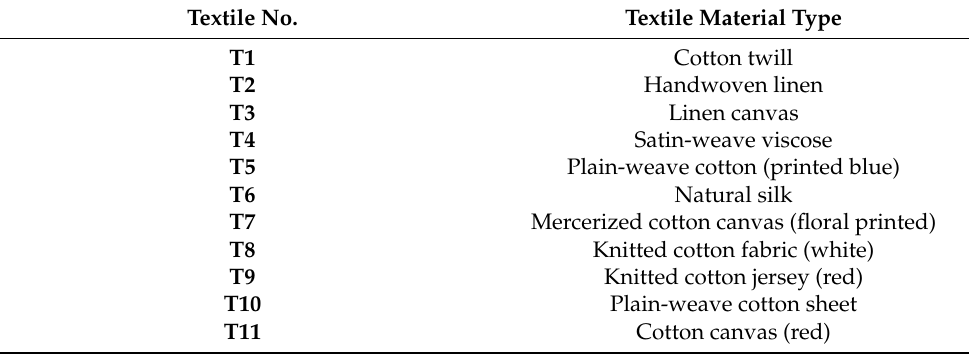
Table 1. Textile materials used in the experiments. Textile